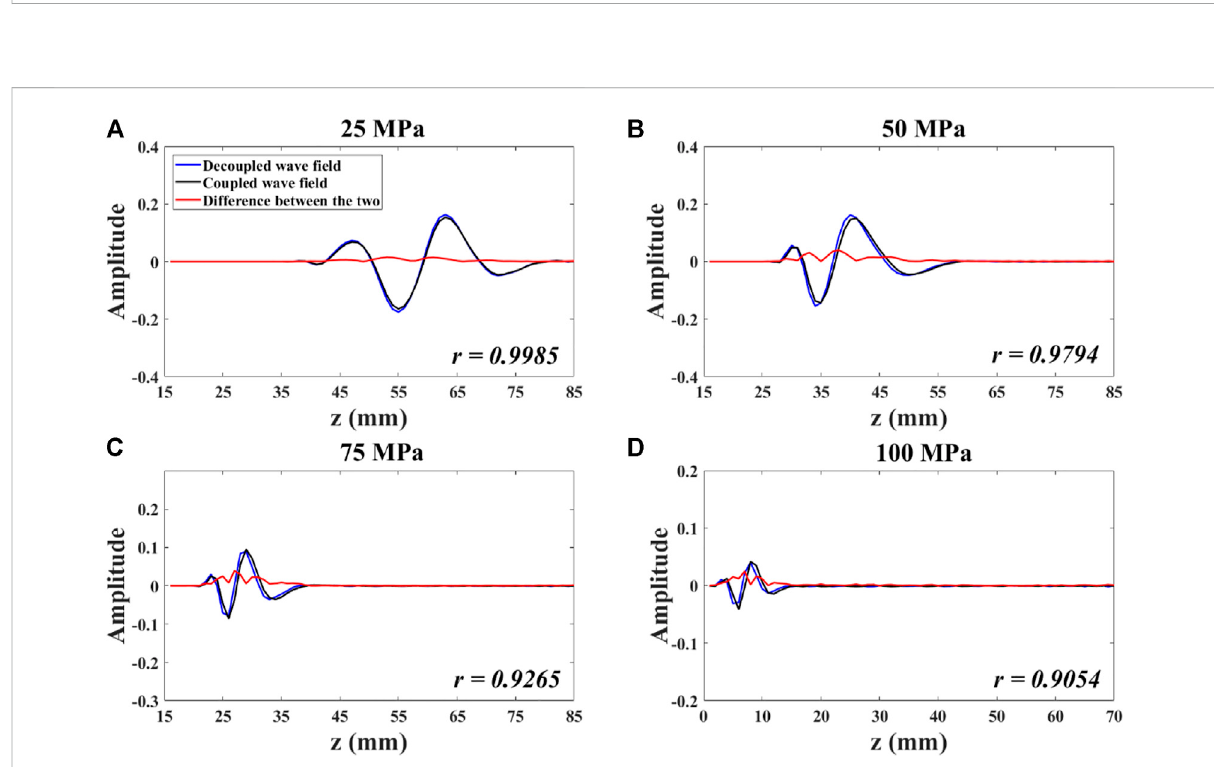
FIGURE 14 Part ofFigure 13( (A) :25MPa; (B) :50MPa; (C) :75MPa; (D) :100MPa).(Redline represents the absolute valueofthe difference betweenthetwo wave fi elds; r represents the correlation between the two curves.). Decoupled acoustoelastic simulation for a three-layer